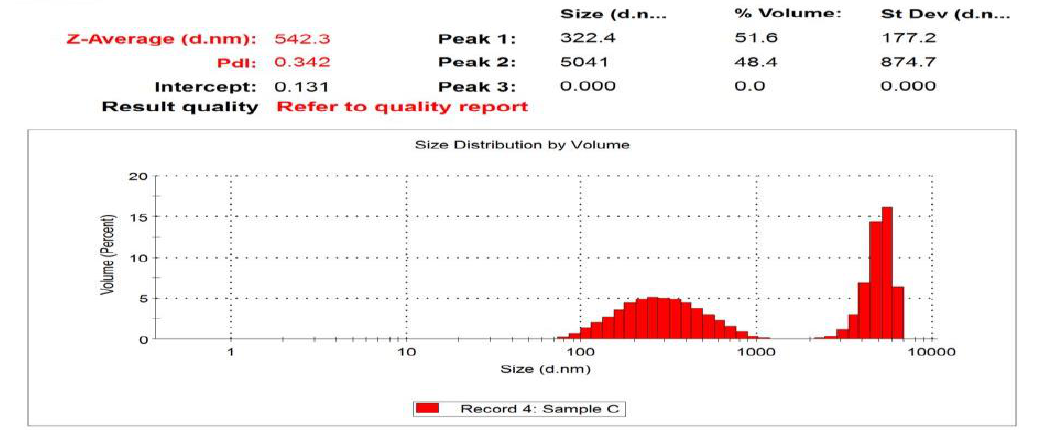
Figure 5: Particle size distribution by percentage volume